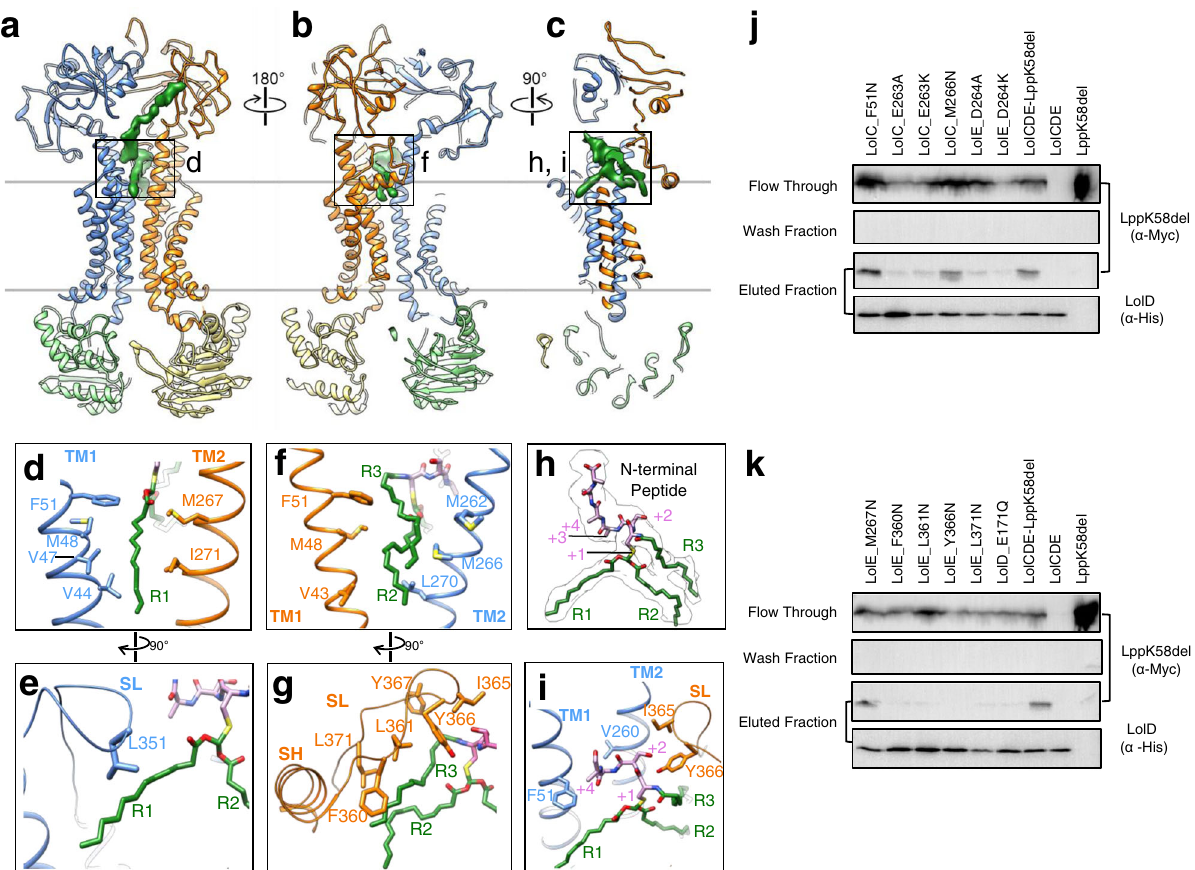
Fig. 2 Lipoprotein interaction with LolCDE. a – c Model of LolCDE with the cryo-EM density of lipoprotein (green), shown as front ( a ), back ( b ), and sectional side ( c ) views. Lol proteins are colored as in Fig. 1. d – i Close-up views of the selected areas indicated in ( a – c ). The lipoprotein is shown with the N-terminal peptide in purple and three acyl chains in green: the N-terminal R3 and cysteine side chain-connected R1 and R2. SH shoulder helix (only in LolE), SL shoulder loop (in LolC and LolE). j , k Co-puri fi cation assay to test Lpp binding to wild-type and mutant LolCDE. LppK58del without the C-terminal lysine residue was used to prevent cell toxicity. Except the last two lanes, where only wild-type LolCDE or LppK58del was individually expressed, all lanes show the results from co-expression of LolCDE and LppK58del. LolCDE was puri fi ed using Ni-NTA via the His tag on LolD. Flow-through, wash, and elute were analyzed by western blot. Data are representative of three independent